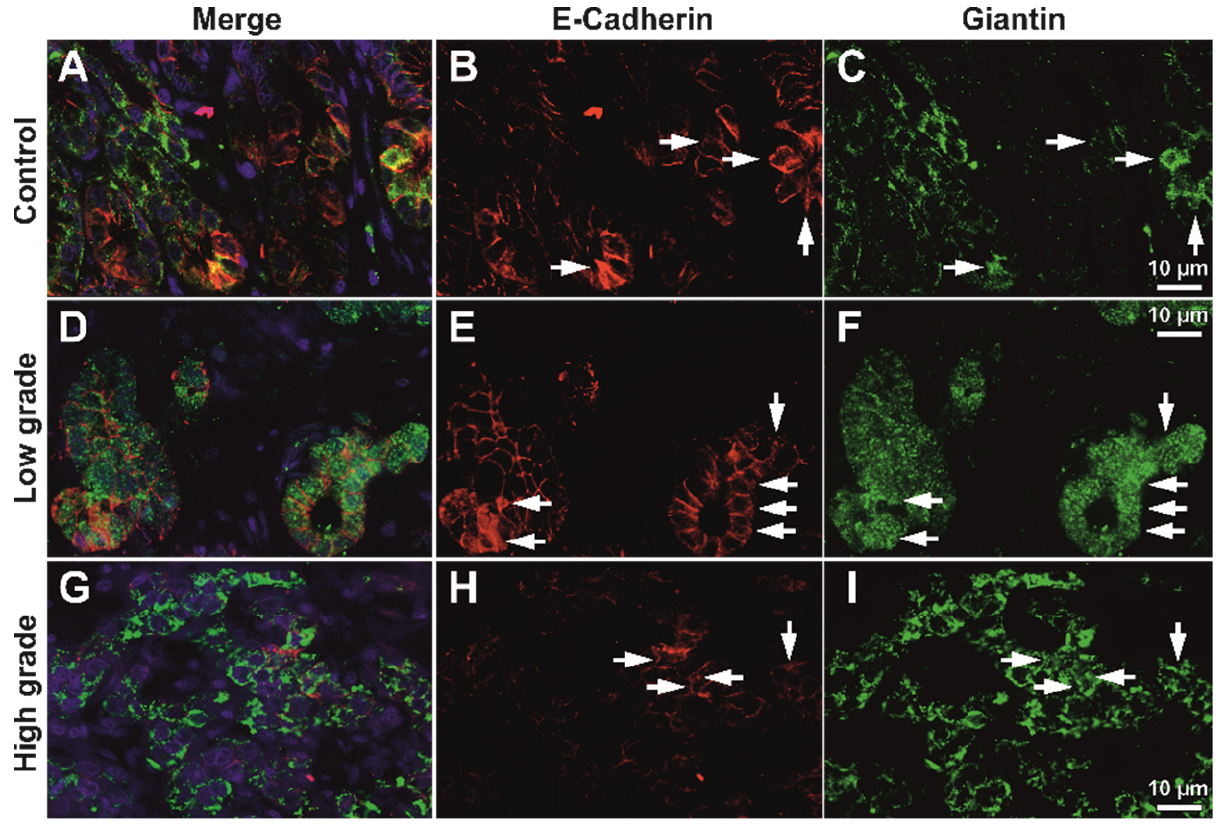
Figure 5. Exemplary deconvolved working images of double immunofluorescence for E-cadherin and Giantin. Epithelia of control tissue ( A – C ); low-grade ( D – F ) and high-grade ( G – I ) adenocarcinoma have been analyzed for expression area and Giantin/E-cadherin overlap. Colocalizations are indicated (arrows) at both membrane and sub-membrane cytoplasmic levels. Scale bar for images A–C, D–F and G–I, 10 μ m.